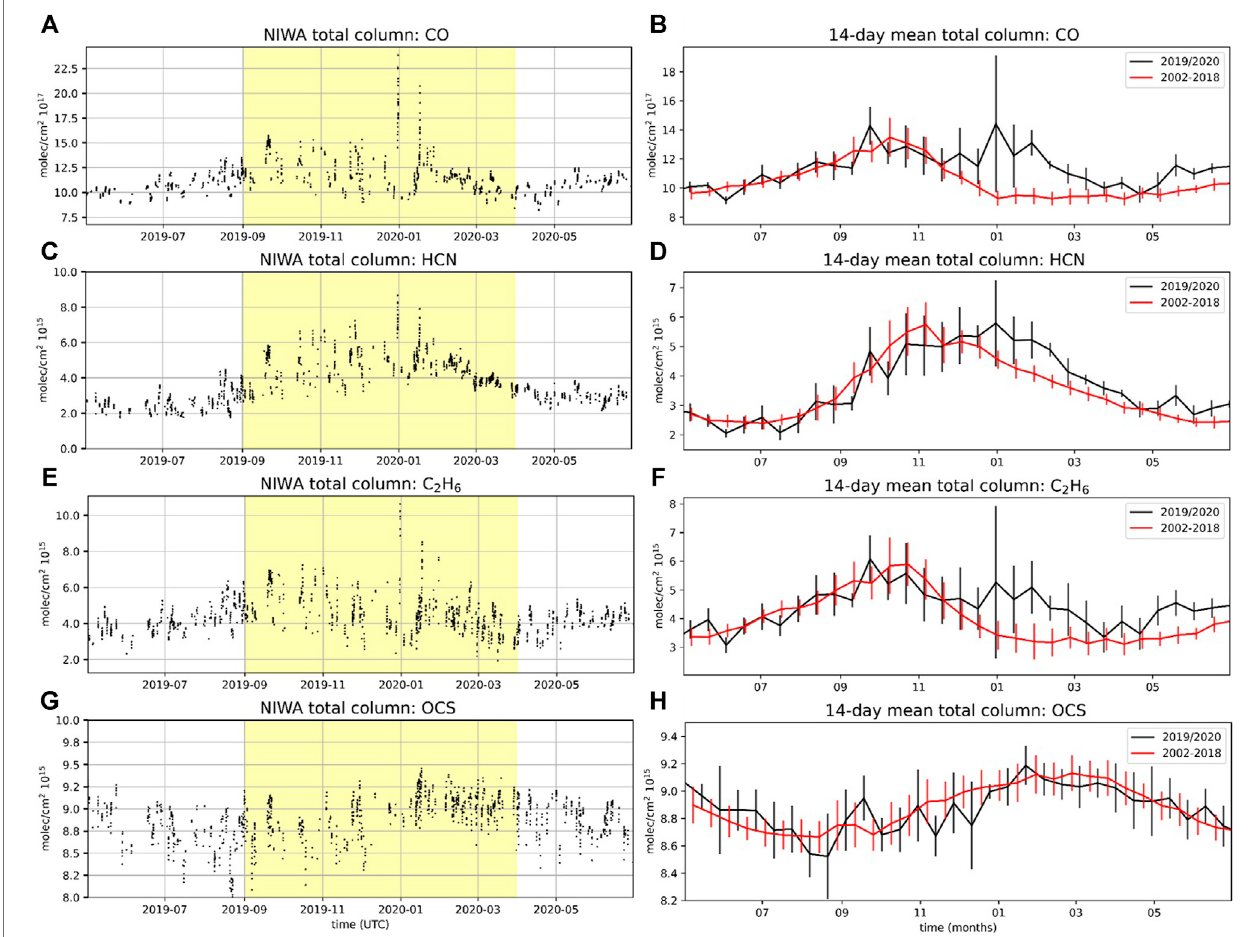
FIGURE 4 | (A) , (C) , (E) and (G) CO, HCN, C 2 H 6 and OCS total column NDACC MIR FTS observations at Lauder, New Zealand, May 2019 to June 2020 respectively. The yellow background indicates the fi re season from September 2019 to March 2020. (B) , (D) , (F) and (H) are 14-day mean total columns (with 1-sigma standard deviation) averaged over the period 2002 to 2018 (red) and for the 2019/2020 period